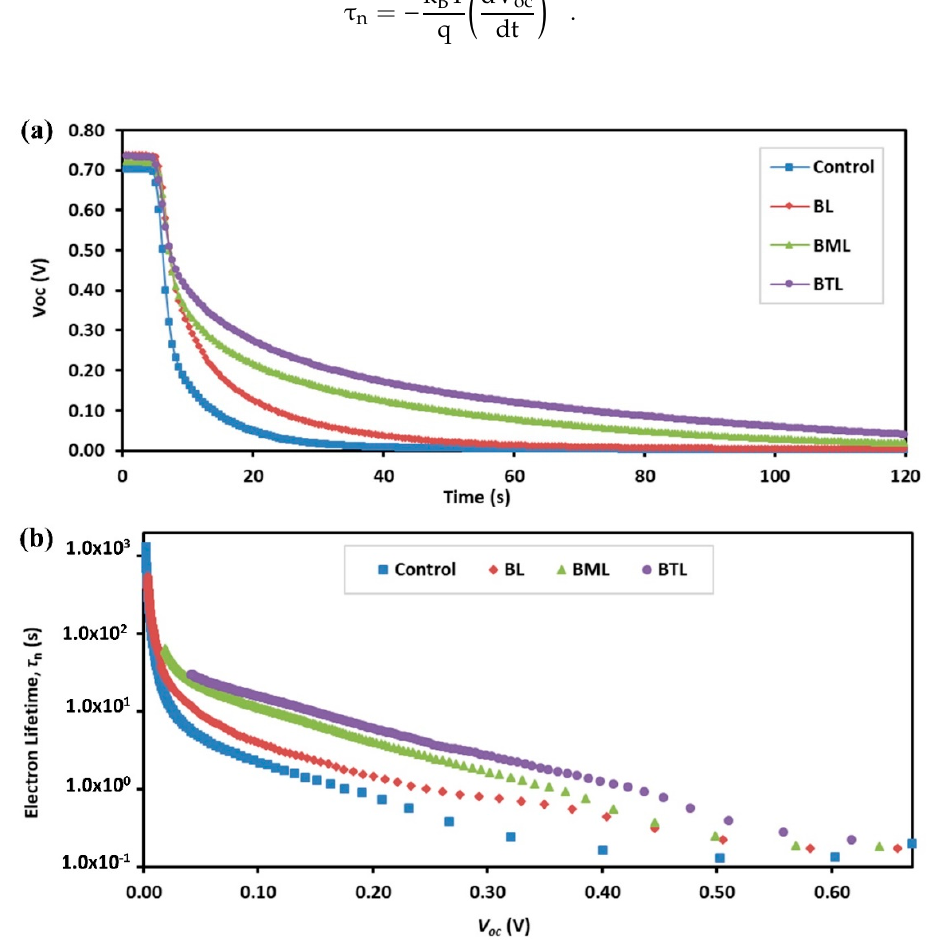
Figure 11. ( a ) Open-circuit voltage decay and ( b ) electron lifetime as a function of V oc.